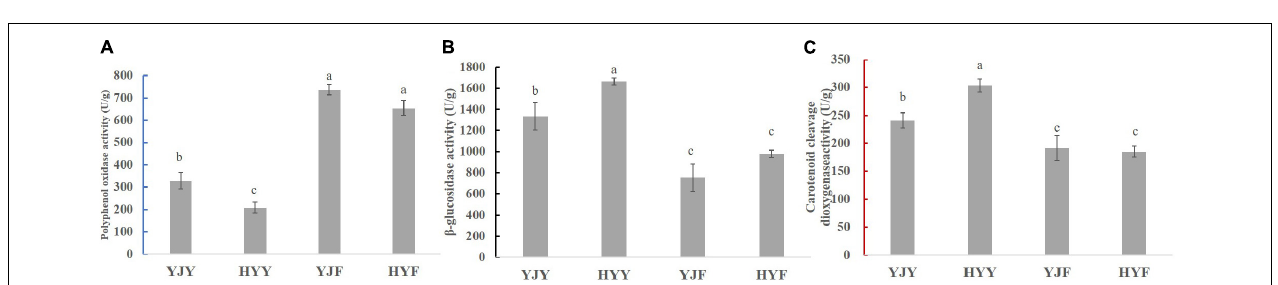
FIGURE 5 | Heat map of carotenoids metabolite clusters in “Yinghong 9” and “Huangyu” fresh and their fermented leaves. Red and green indicate higher and lower abundances in respective. YJY was “Yinghong 9” fresh leaves, YJF was “Yinghong 9” fermented leaves; HYY was “Huangyu” fresh leaves, HYF was “Huangyu” fermented leaves.